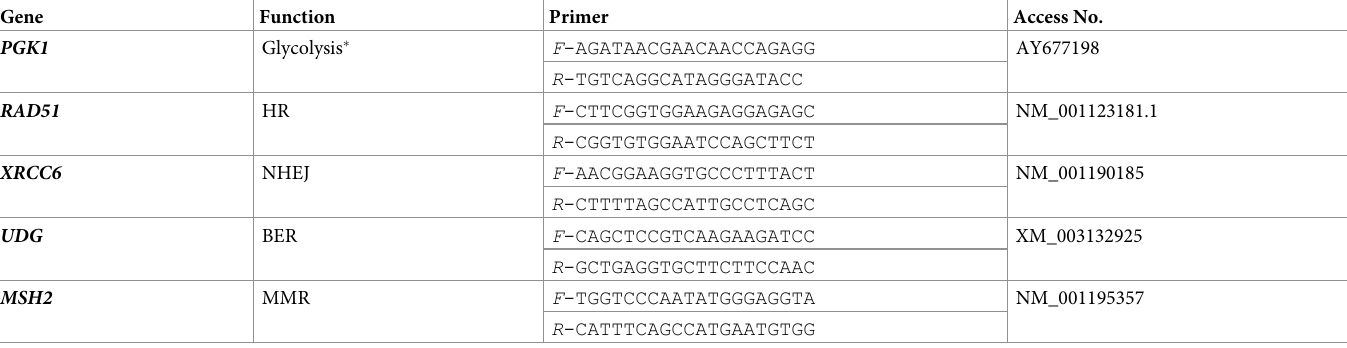
Table 1. Primers used in the present